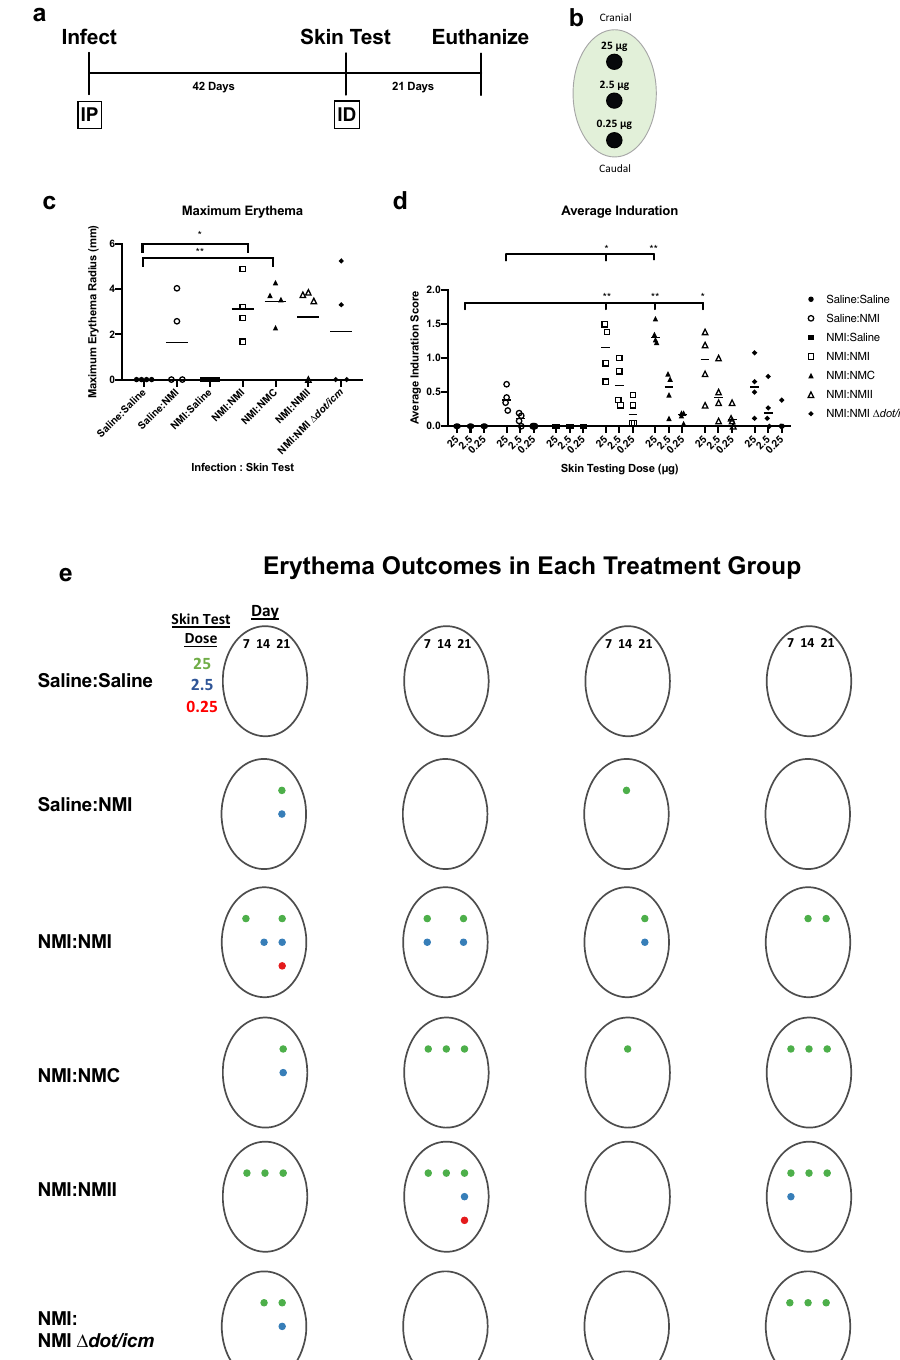
Fig. 7 Skin testing reveals the contribution of LPS and the T4BSS of C. burnetii in post-vaccination hypersensitivity. a Animals were infected intraperitoneally (IP) with 10 6 NMI, or mock infected with saline, allowed to rest for 42 days, then intradermally (ID) injected (skin tested) with 25, 2.5, and 0.25 μ g fi xed C. burnetii or saline b Animals were then monitored for 21 days and euthanized. Erythema was measured at each skin testing site and is represented by maximum erythema radius (mm) at any day or skin testing dose c Average induration over the entire monitoring period is presented in ( d ). Overall erythema outcomes for each animal in each treatment group is presented in ( e ); both day of measurement (columns) and skin testing site dose (row) are represented. A colored dot represents measurable erythema at the corresponding day post-skin test and skin test lesion site. Maximum erythema and average induration were evaluated based on differences in group means (horizontal bar) with associated con fi dence intervals. For each reported comparison, p -values were computed at the α = 0.05 level for two-sided two-sample t tests, allowing for unequal variances between groups. No adjustment was made for multiple comparisons due to the sample sizes ( n = 4) and the descriptive nature of the study. * p ≤ 0.05 and ** p ≤